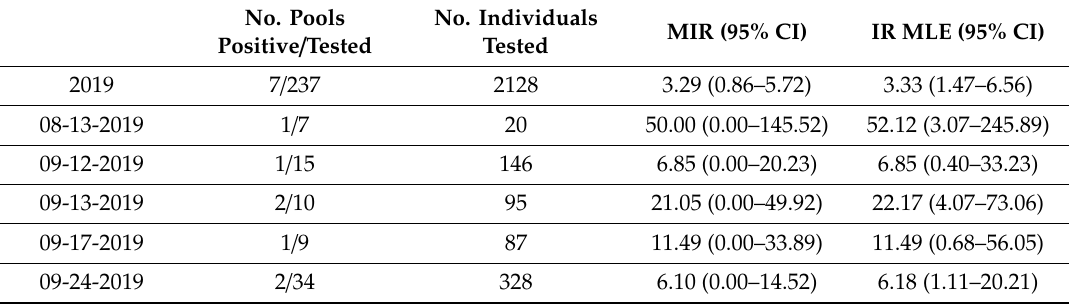
Table 3. Minimum infection rates (MIR) and infection rated per maximum likelihood estimate (IR MLE) for Cx. pipiens complex females collected in the Tierpark Berlin in